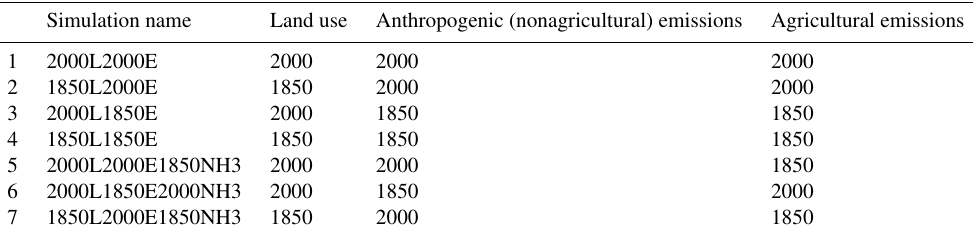
Table 1. List of GEOS-Chem simulations with relevant input parameters.